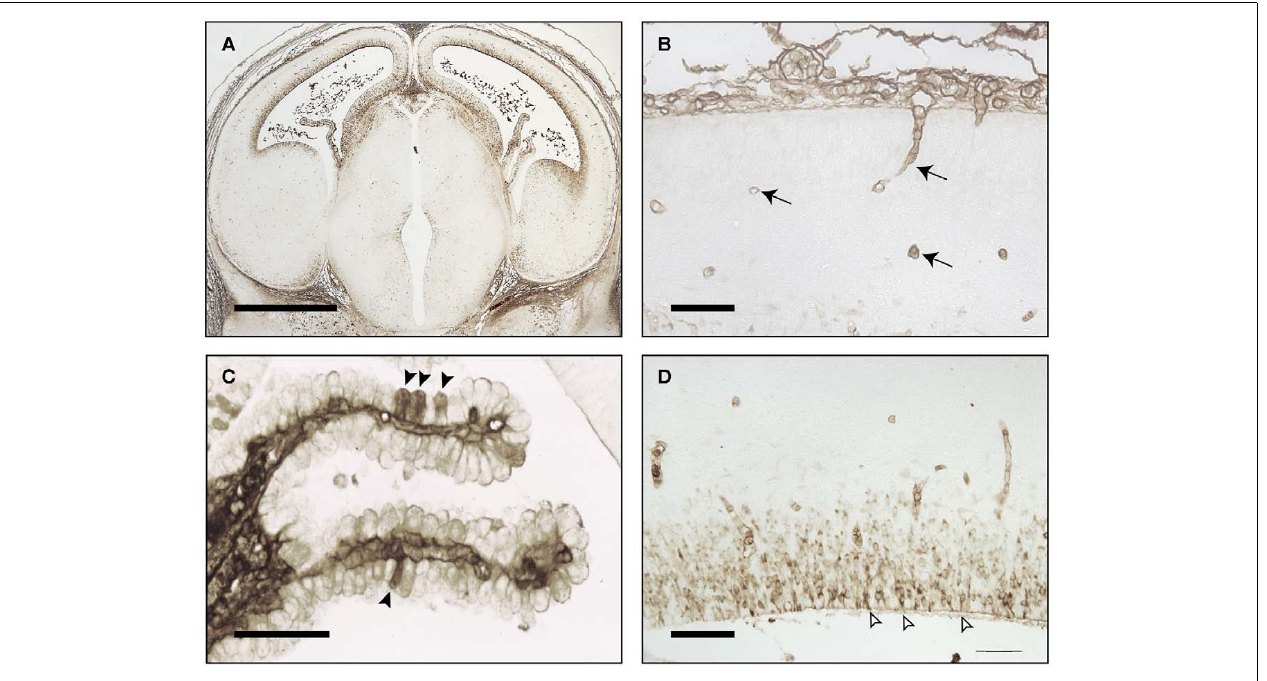
plexus: immunostaining in some epithelial cells (arrowheads) and stroma. (D) Immunostaining in neuroependymal cells and blood vessels, not in brain parenchyma outside neuroependyma. Open arrows: sites of strap junctions. Images reproduced from Saunders and Habgood (2011). Scale bars: (A) , 100 μ m; (B,D) , 25 μ m; (C) , 50 μ